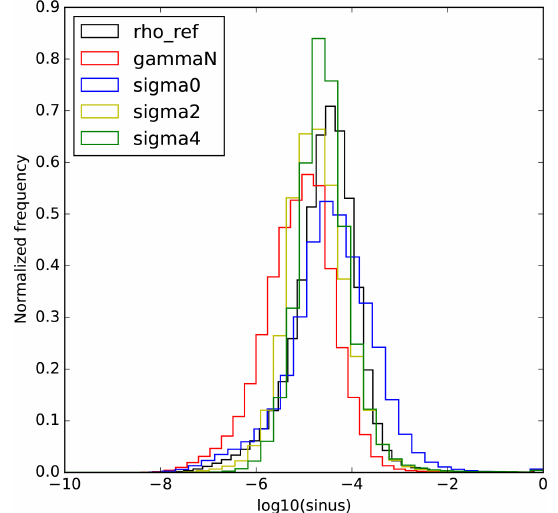
Figure 3. Histogram of the decimal logarithm of the squared sine between the gradient of γ and the neutral vector d weighted by the volume of each point. log 10 (red), σ 0 (blue), σ 2 (yellow) and σ 4